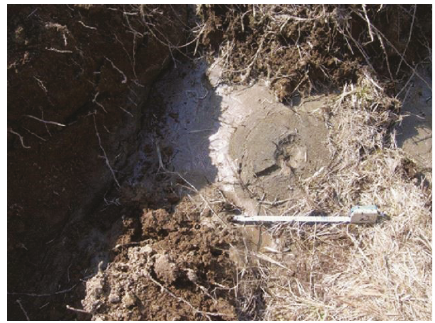
Figure 9: Sand boiling in the embankment crack